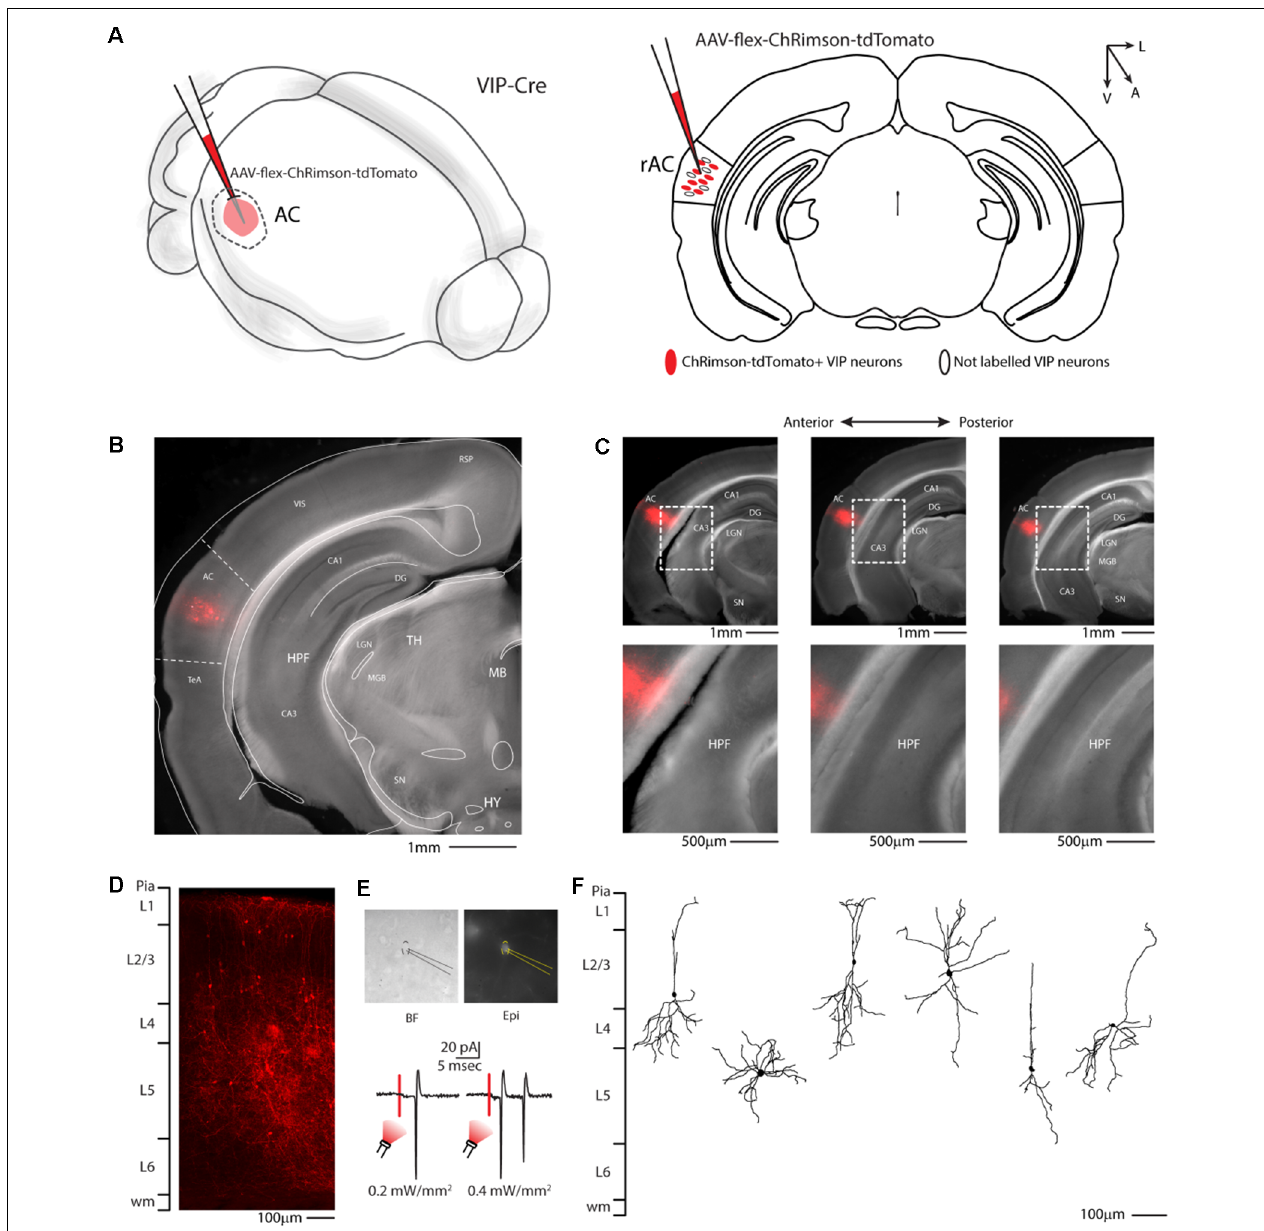
FIGURE 2 | Auditory cortex injection of AAV-flex-ChRimson-tdTomato. (A) Schematic representation of right auditory cortex viral injection. (B) Representative coronal section of an acute slice of the injection site (200 µ m thick), with bright field (gray) and tdTomato expressing neurons (red). The Allen brain atlas coronal table superimposed for reference indicates the correct targeting of the Auditory cortex. Scale bar: 1 mm. (C) Top panel: antero-posterior and dorsal ventral spread of ChRimson-tdTomato injection in AC. Scale Bars: 1 mm. Bottom panel: high magnification image of the injection site showing no evidence of ChRimson-tdTomato deposit or spillover in the hippocampus and/or other subcortical structures. Scale Bars: 500 µ m. (D) High magnification confocal image of the injection site showing tdTomato expressing neurons. Scale bar: 100 µ m. (E) Top panel: bright field and epifluorescence image of tdTomato expressing VIP neuron used in whole-cell patch clamp recordings. Bottom panel: example of responses recorded from a VIP neuron using red LED at two different powers. (F) Reconstruction of the dendritic arborization of biocytin-filled tdTomato expressing VIP neurons. Scale bar: 100 µ m. RSP, retrosplenial cortex; VIS, visual cortex; TeA, temporal association cortex; AC, auditory cortex; HPF, hippocampal formation; CA1, Cornu Ammonis of the hippocampus subfield 1; CA3, Cornu Ammonis of the hippocampus subfield 3; DG, dentate gyrus; TH, thalamus; MGB, medial geniculate body; LGN, lateral geniculate nucleus; MB, midbrain; SN, substantia nigra; HY,